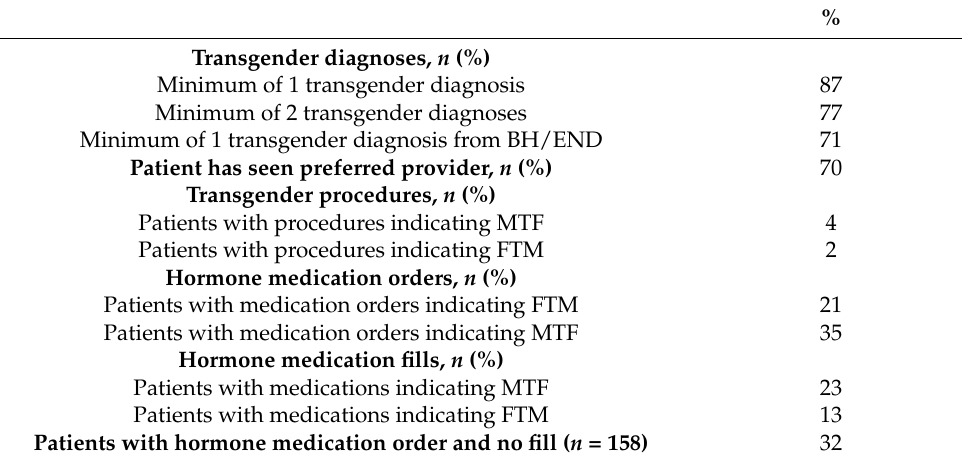
Table 2. Characteristics specific to the transgender cohort.